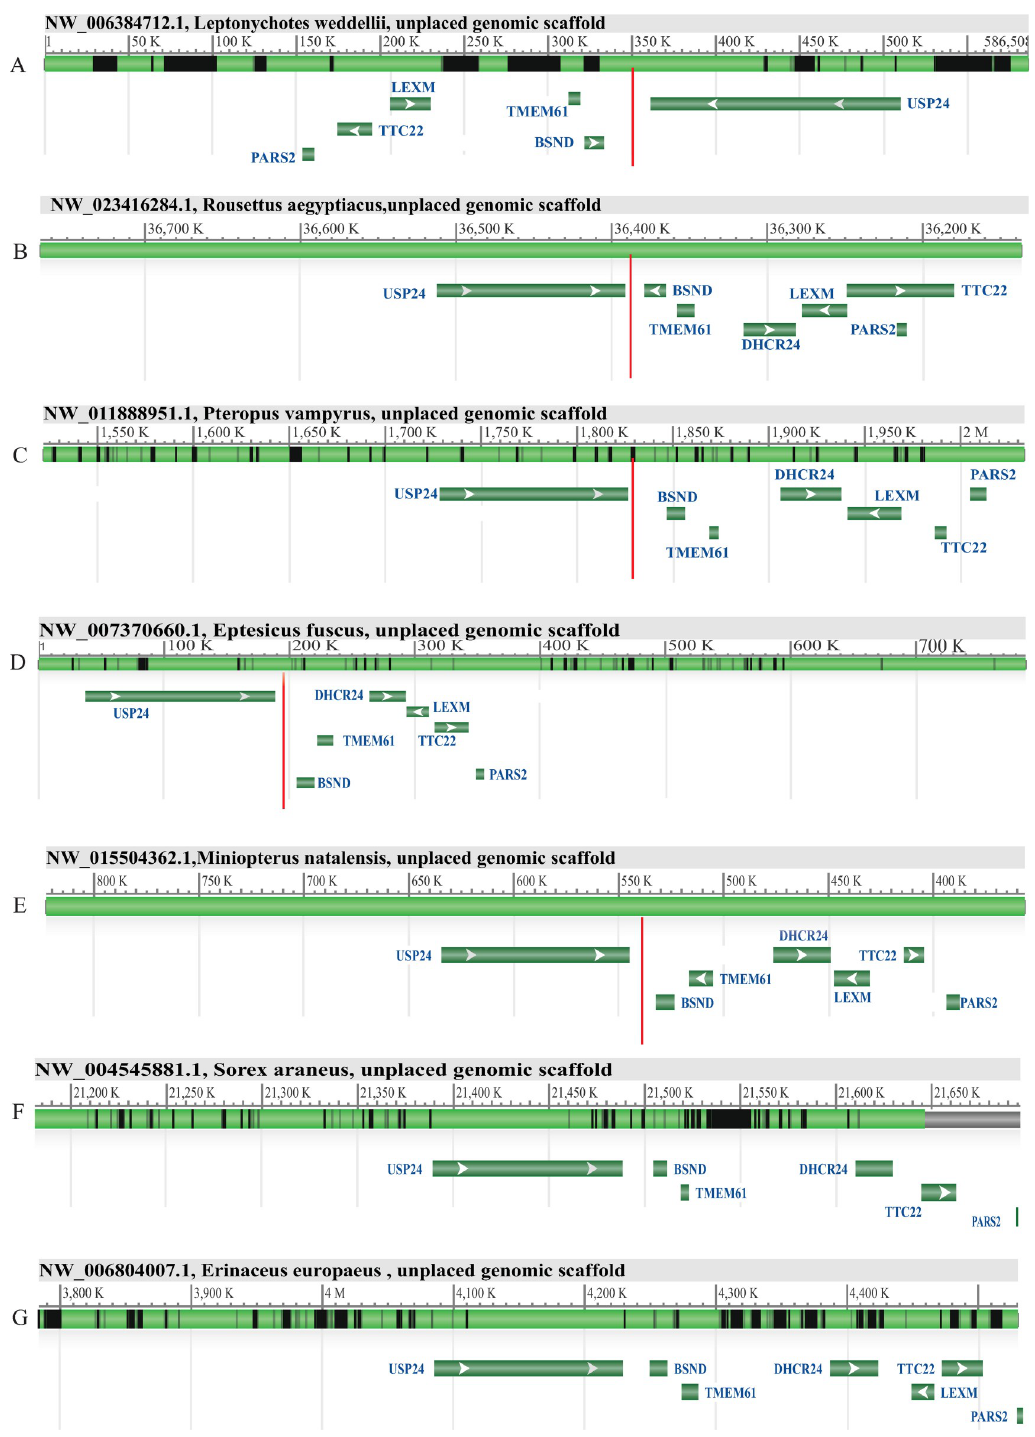
Fig 3. The comparative genomic region around PCSK9 gene remnants in species with putatively lost PCSK9. The red vertical lines indicate the genomic location of the PCSK9 remnants.